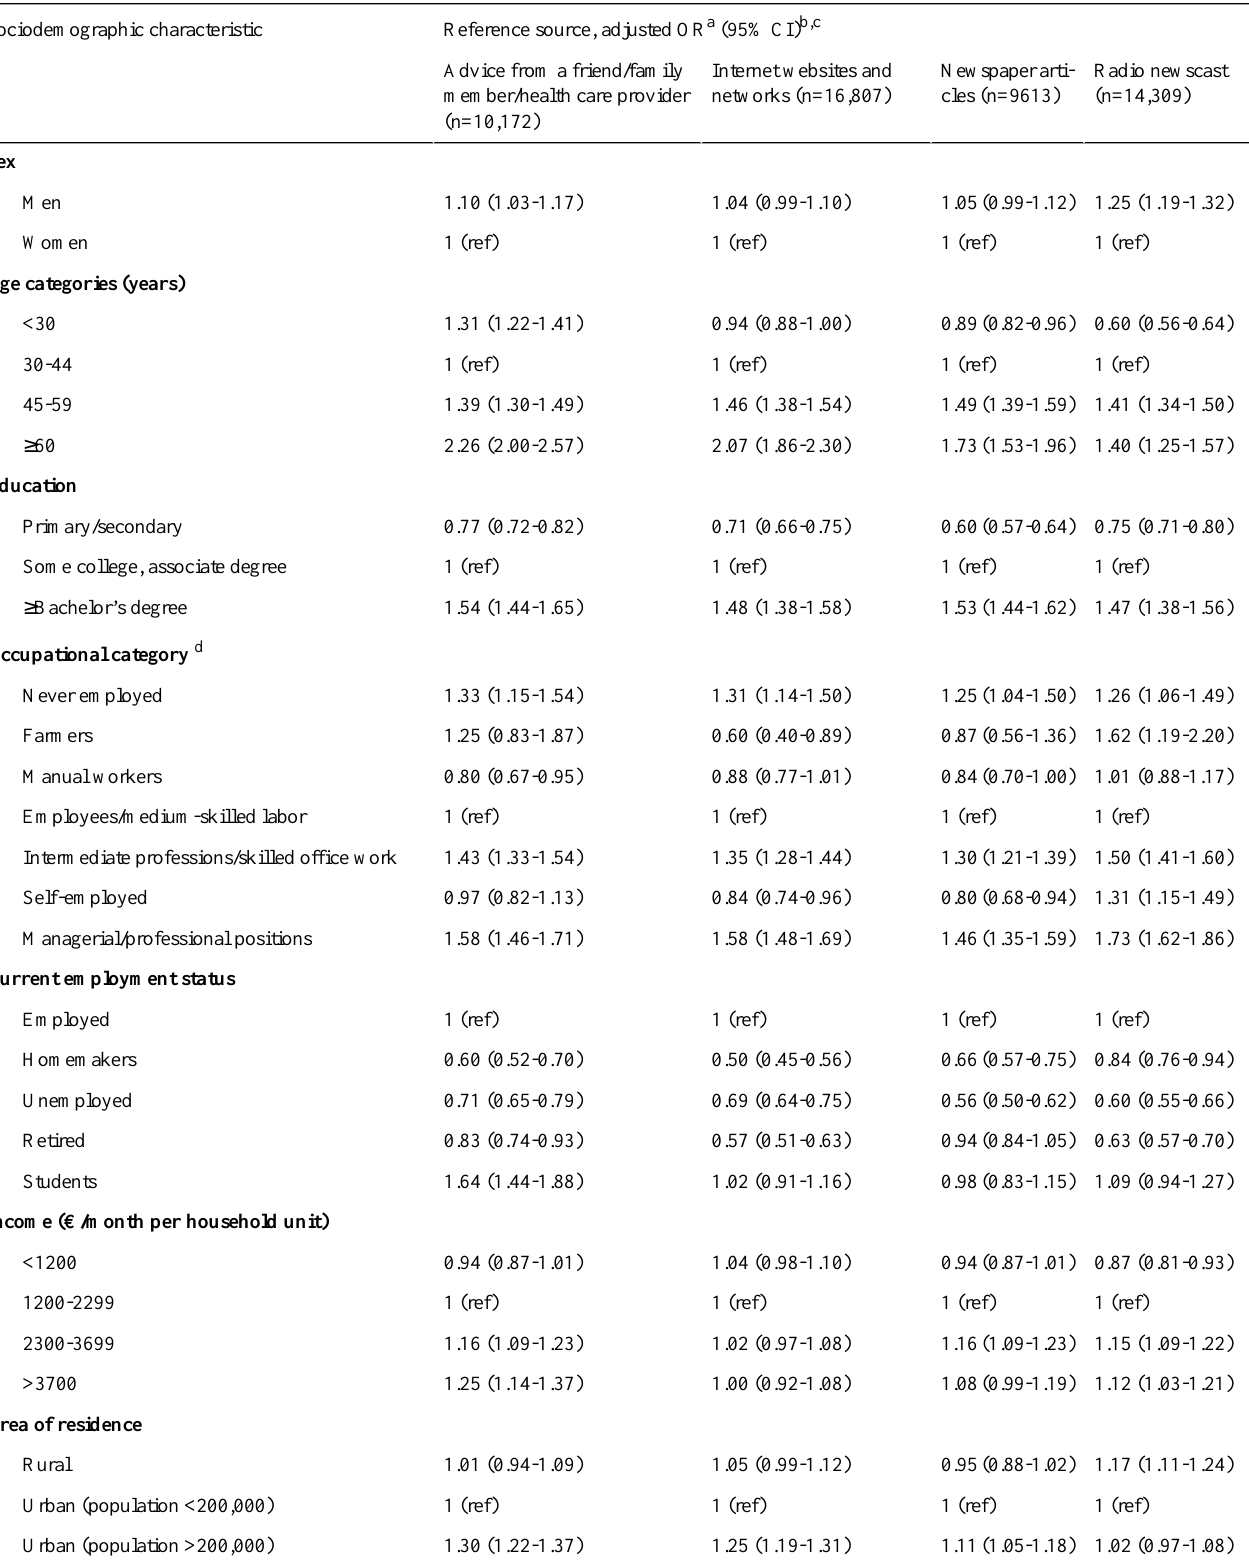
Table 3. Multivariate associations between the participant sociodemographic profiles and recruitment source using television as reference